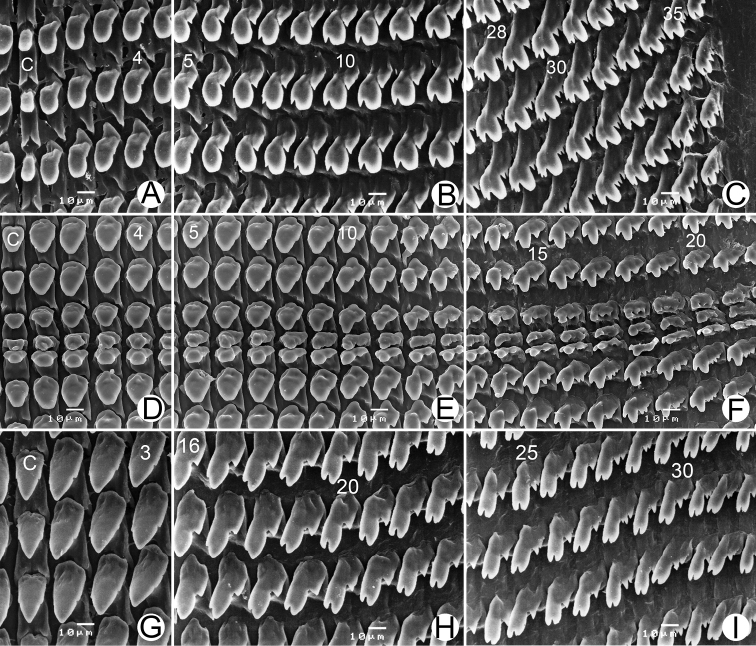
Radula. A–CGanesella
carinellaD–FGanesella
rhombostoma and G–IGlobotrochus
onesteraA, D, G central tooth with the first to the second lateral teeth B, E, H lateral teeth with the tricuspid marginal teeth transition C, F, I outermost marginal teeth. Numbers indicate order of lateral and marginal teeth. Central tooth indicated by ‘C’.